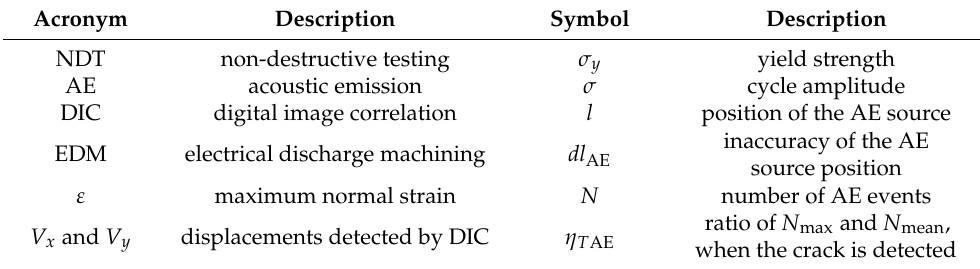
Table 1. List of acronyms and symbols used in the